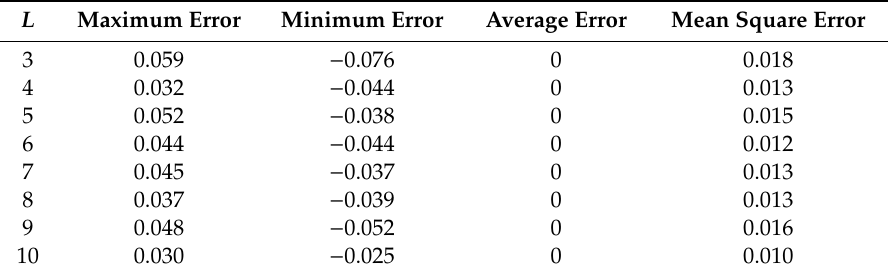
Table 1. Capacity prediction results of di ff erent hidden layer nodes